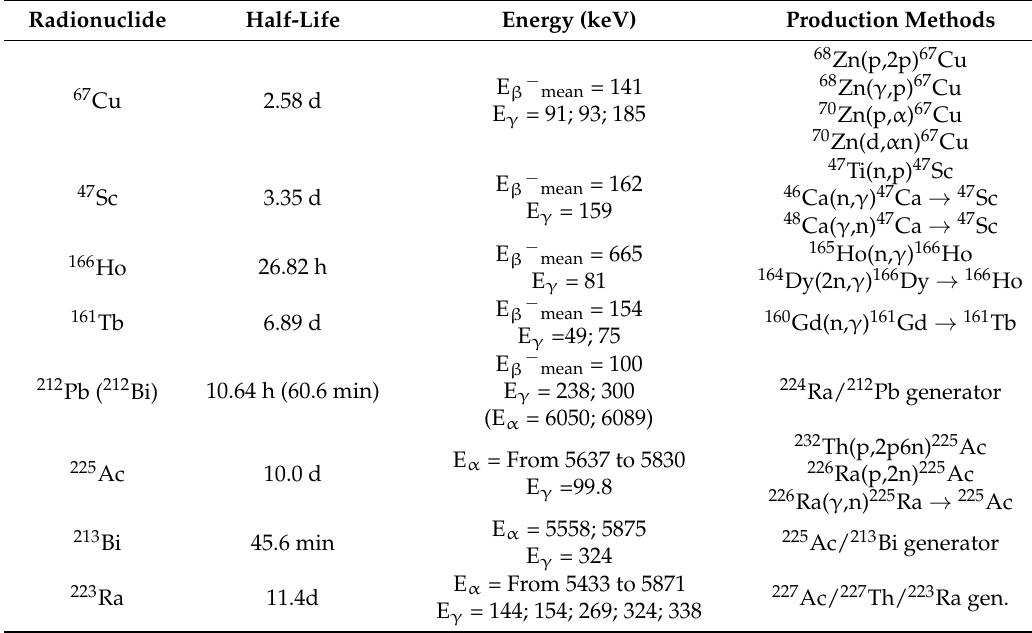
Table 2. Relevant physical characteristics of principal emergent therapeutic radionuclides